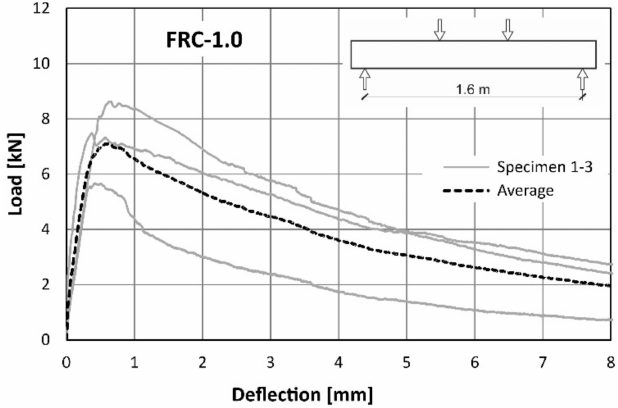
Figure 11. Load–deflection curves from flexural tests on